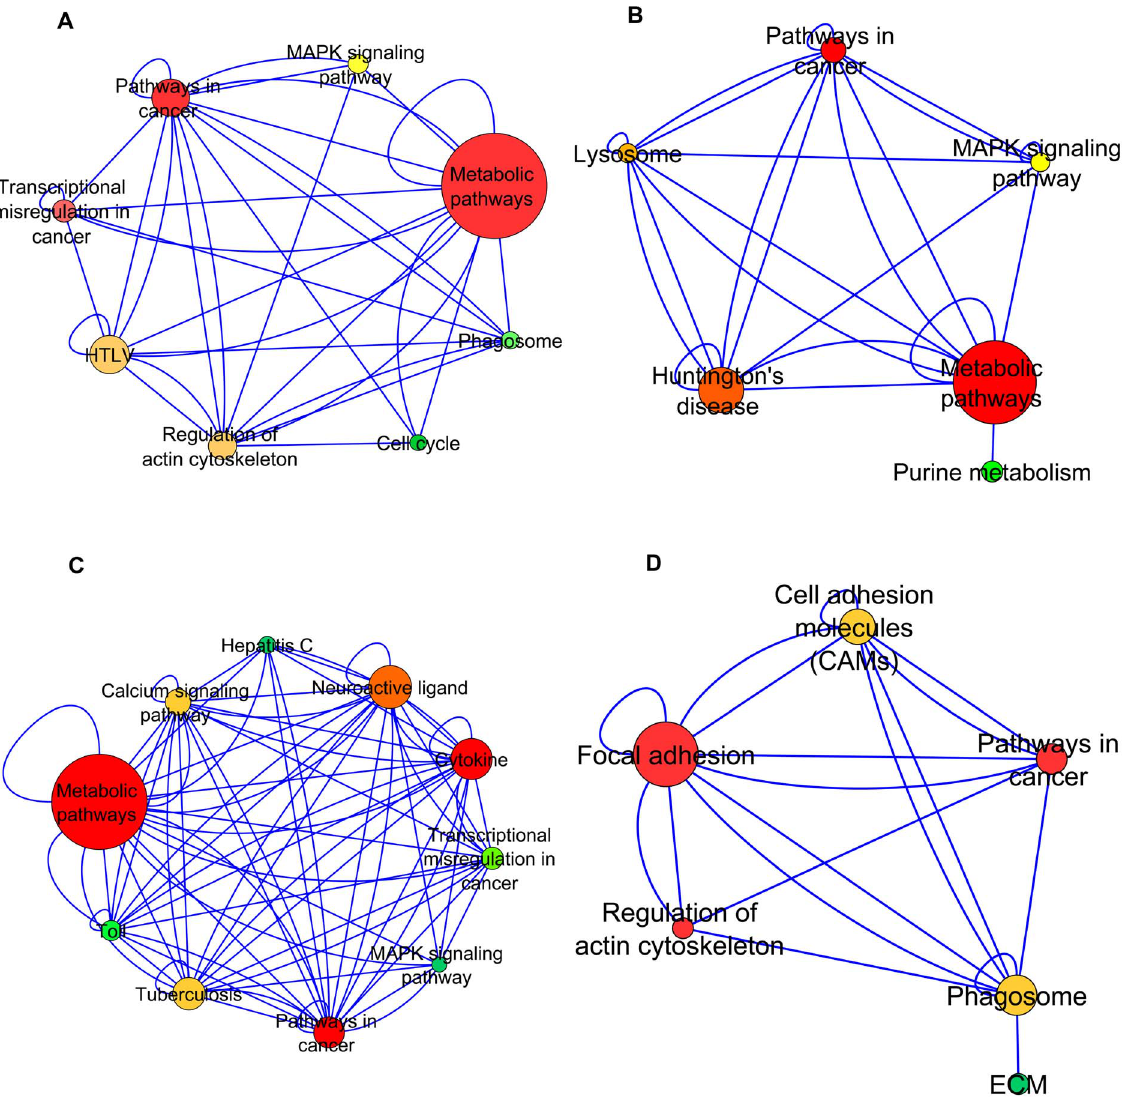
Figure 3. Pathway Projection Networks. Representation of communities (of interest) from the perspective of the pathways. Nodes in the PPNs are derived from (and are representative of) the pathway(s) that the constituent genes correspond to. The edges between the pathway-nodes represent the connections between the underlying genes in the original network. The nodes are color-coded according to the degree (measure of connectivity between the pathways) and size-coded according to the pathway cardinality of the node (number of genes from the community that correspond to that pathway). The transformation technique that was employed to generate an equivalent network in terms of the constituent pathways for each community is described in the Methods section [also schematically presented in the flowchart in Figure